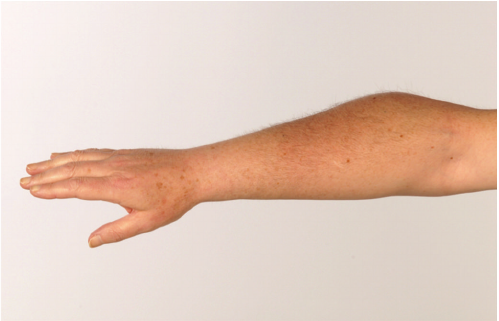
Figure 2: Right forearm—lesion on extensor compartment of right forearm measuring 10 ×